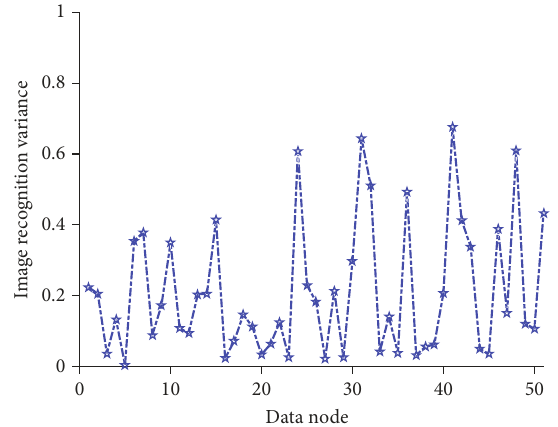
Figure 9: Line graph of recognition deviation after image